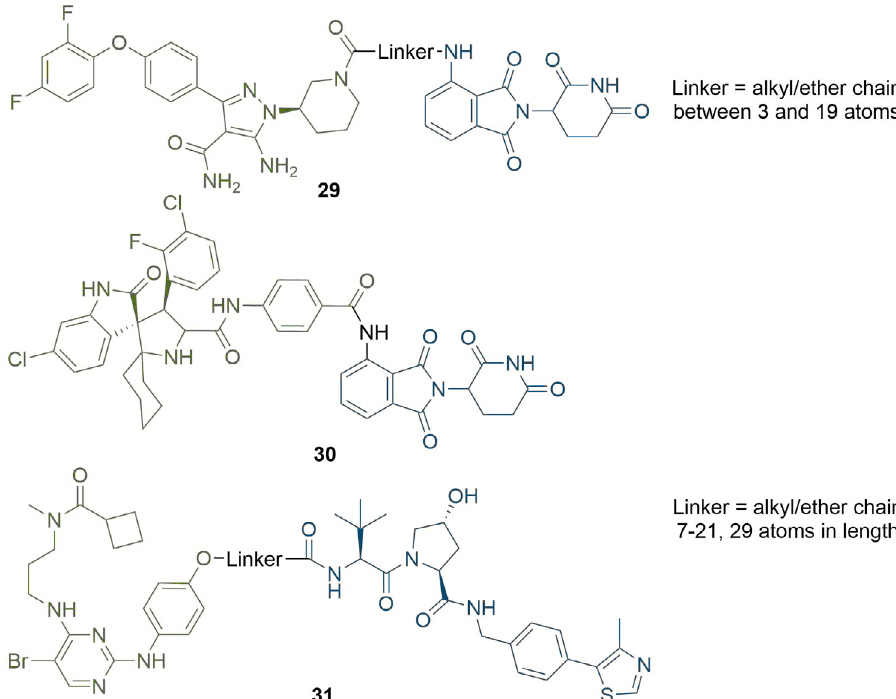
Figure 7. Structures of representative PROTACs with PEG/alkyl linkers. BTK degraders (29) where the linkers are alkyl/ether chains of various combinations between 3 and 19 atoms. MDM2-targeting PROTAC with direct conjugation of the warhead to the anchor (30), although this did not function as a degrader. TBK1 PROTACs with alkyl/ether linkers between 7 and 29 atoms in length (31). In all PROTACs, the anchor is coloured blue and the warhead